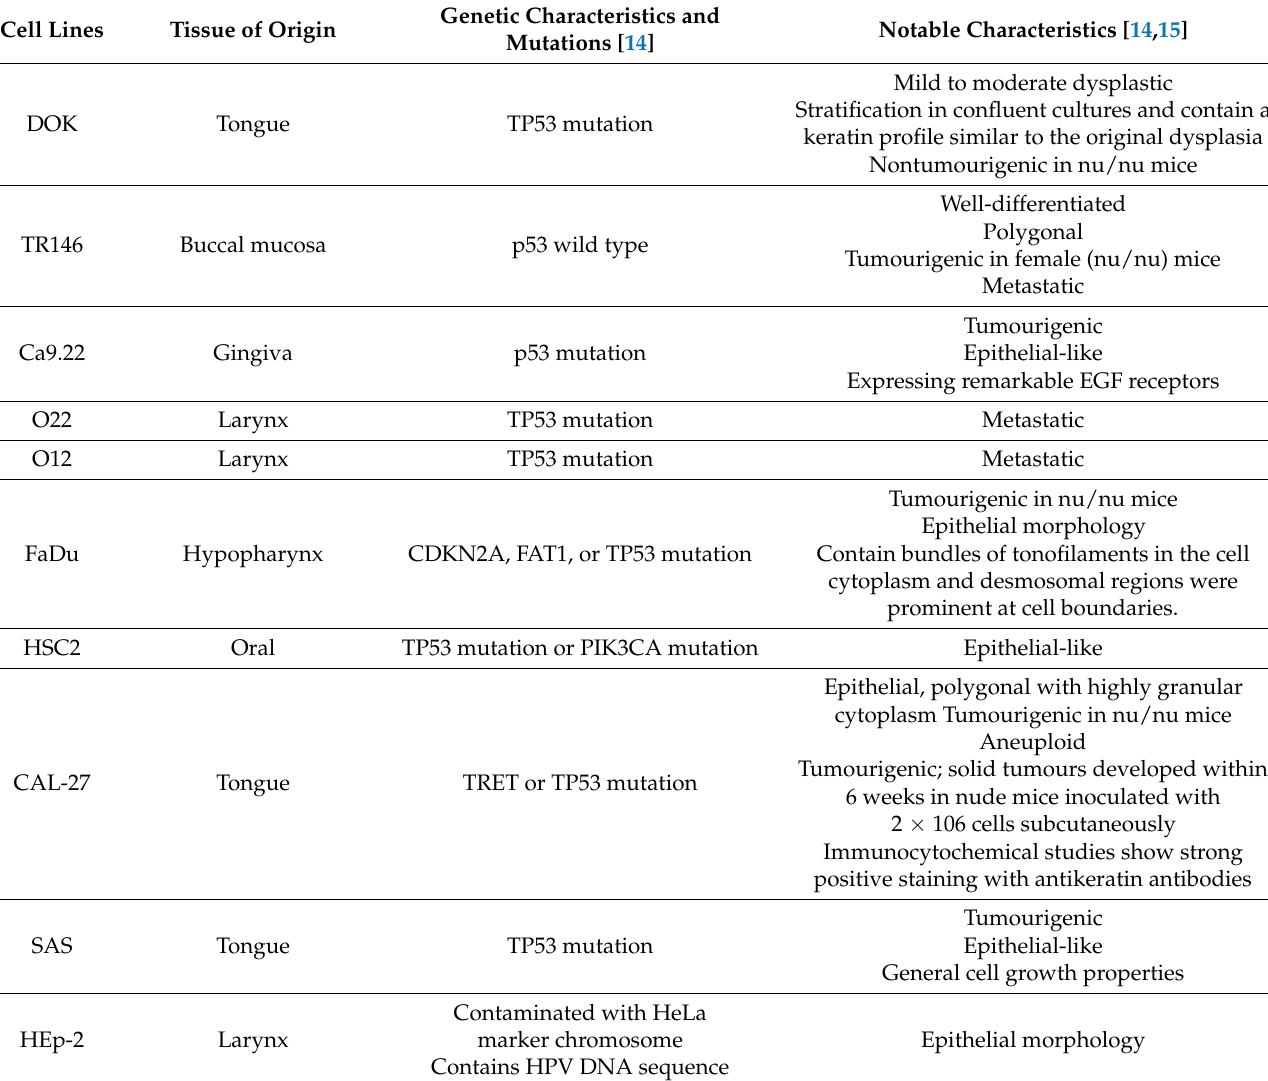
Table 2. Properties of HNSCC cell lines: tissue of origin, genetic characteristics and mutations, and notable characteristics from the 8